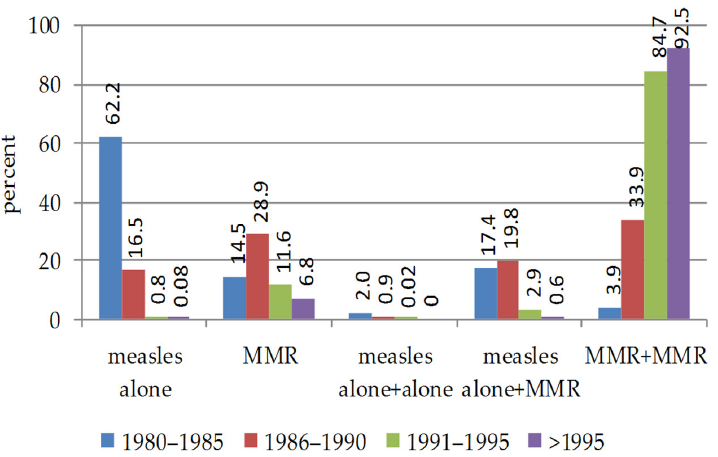
Figure 2. Percentage of vaccinated students according to adopted vaccination schedule. They are subdivided according to year of birth group. The Public Office certified that the measles vaccine was administered according to one dose schedule, alone or MMR, or two doses (two doses of measles alone, a dose of measles alone plus MMR, or two doses of MMR). By the vaccination certificate (data not shown), students vaccinated once received the vaccine dose at a significantly ( p < 0.0001) later age as compared to those vaccinated twice